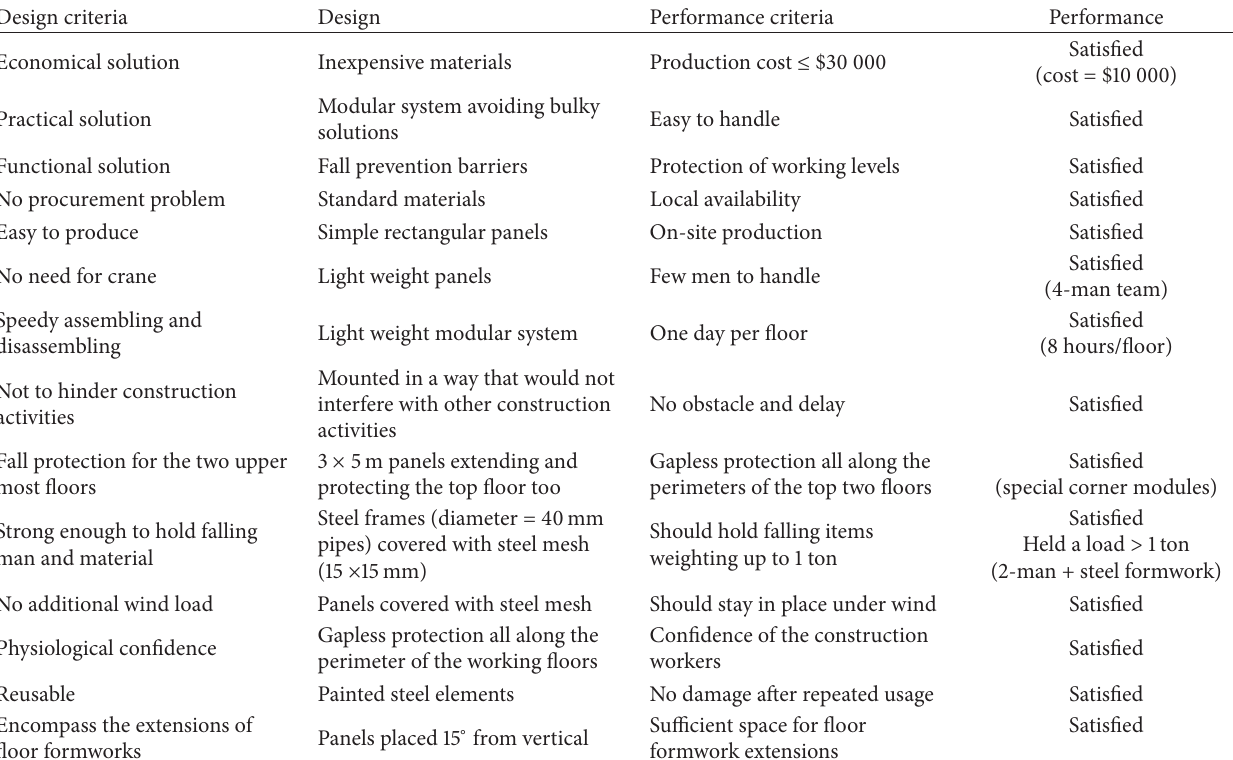
Table 1: Design and performance criteria of